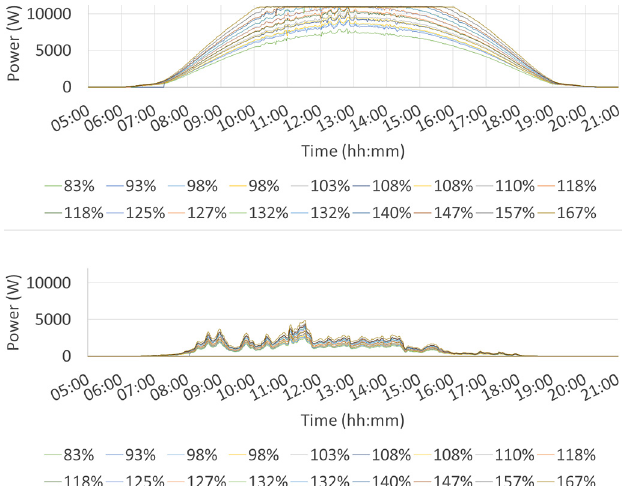
Fig. 7. Distribution of the output power (W) over a sunny (top set of curves) and a cloudy (bottom set of curves) day of 15 identical 10kW string inverters with different ILRs (Inverter Loading Ratios), showing the clipping of power that takes place in sunny days when inverters are undersized (high